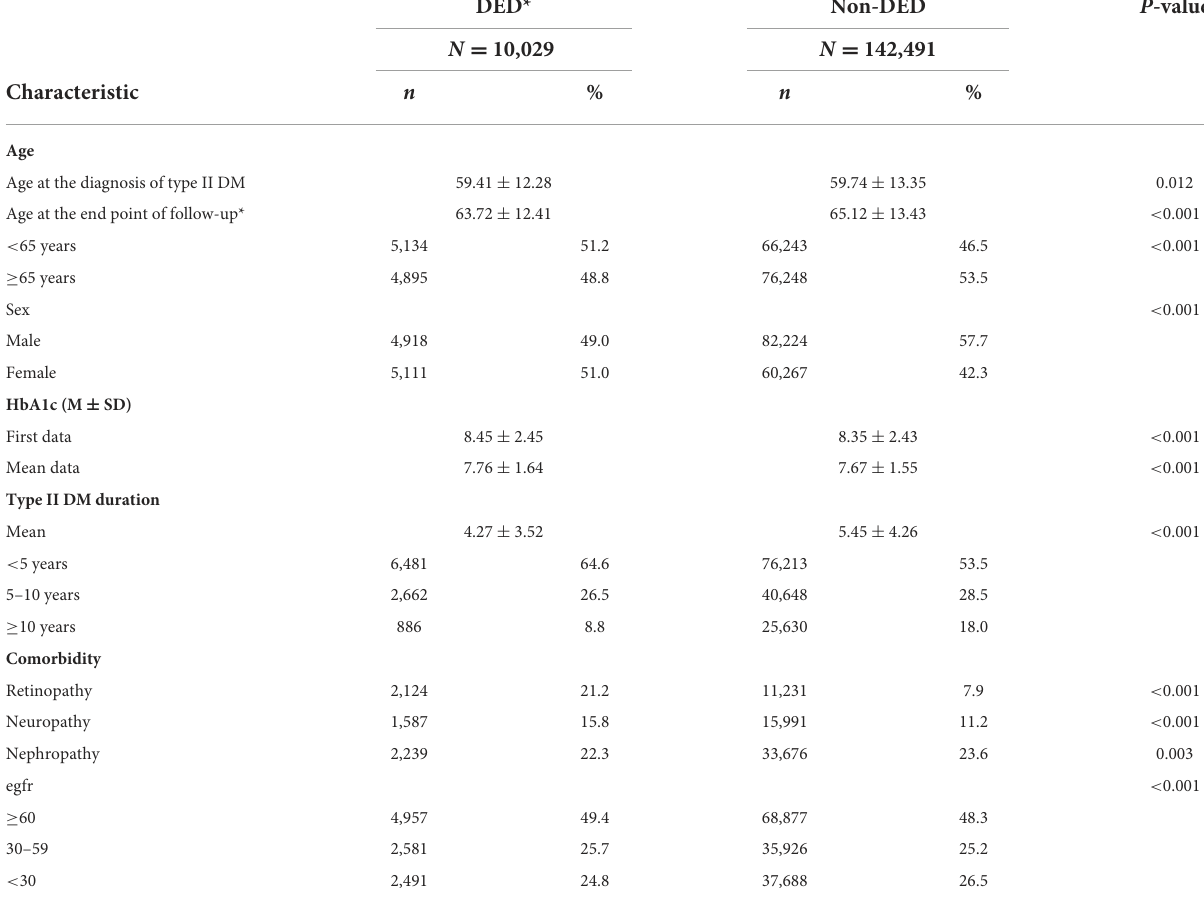
TABLE 1 Demographics and characteristics of dry eye disease (DED) and non-dry eye disease (non-DED) groups in patients with type II diabetes mellitus. DED* Non-DED P -value N =